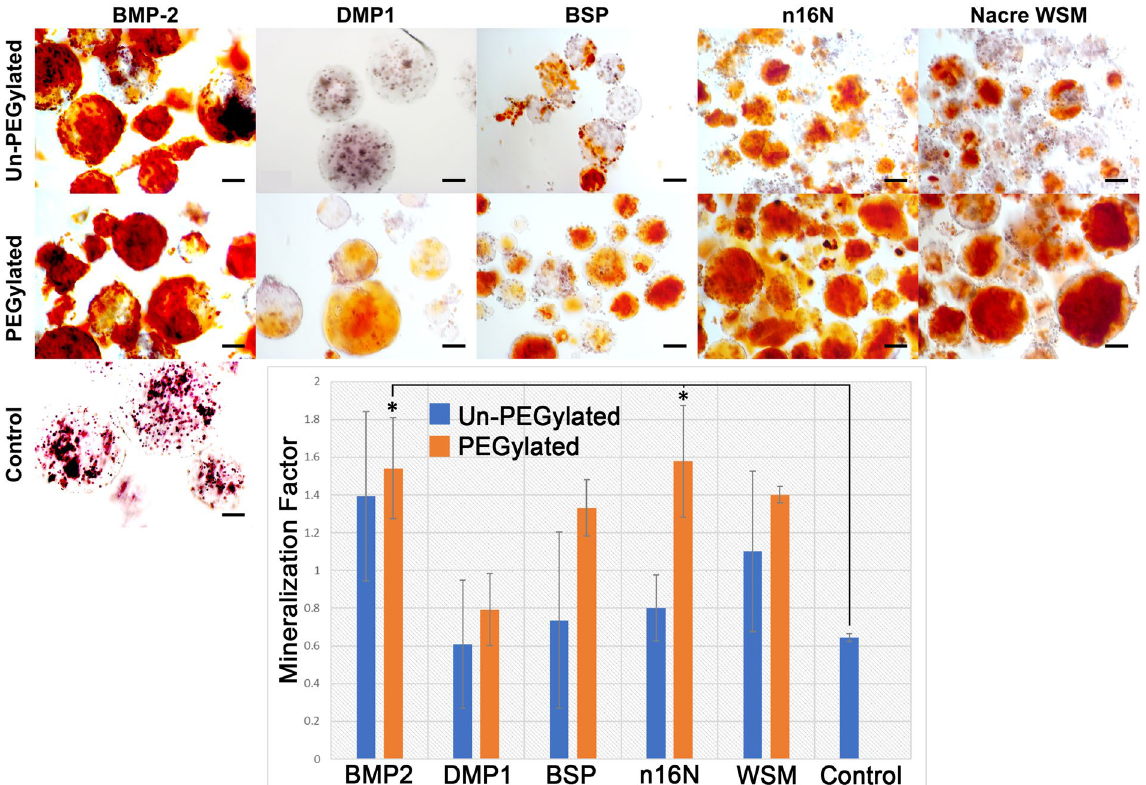
Figure 7. Microencapsulated MC3T3-E1 cells stained with ARS. Scale bars are 100 µm. Error bars represent standard deviation. Asterisks denote significant difference compared to protein-negative controls ( p < 0.05).